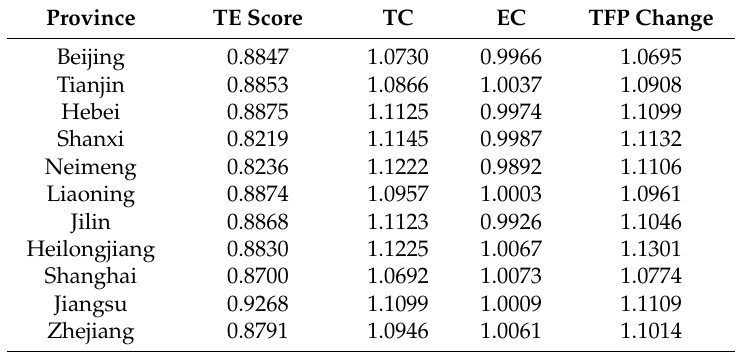
Table 4. The average of TE, TC, EC, and theTFP index of the provinces from 2002 to